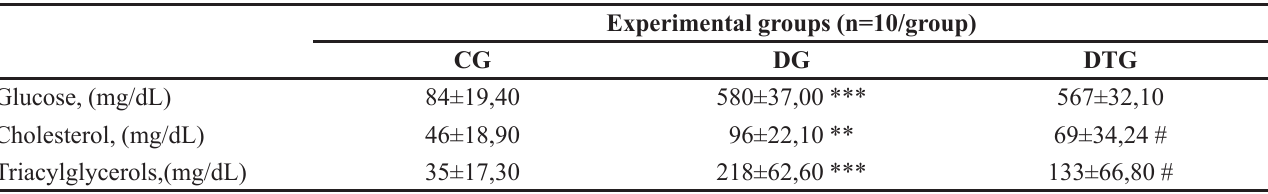
TABLE I - Biochemical analyses from Glucose, cholesterol and triglycerides